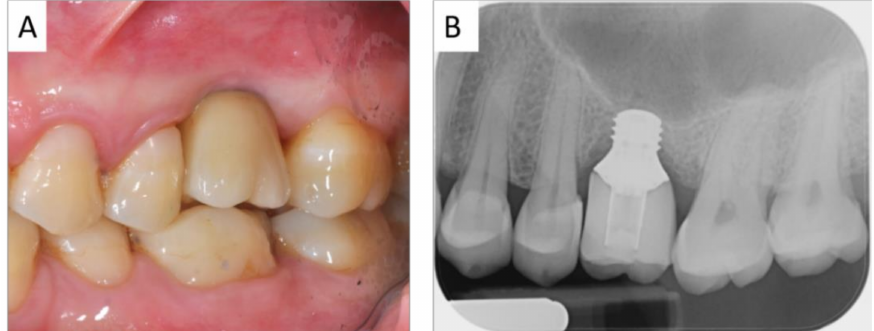
Figure 6. Clinical ( A ) and radiological ( B ) view after implant loading.